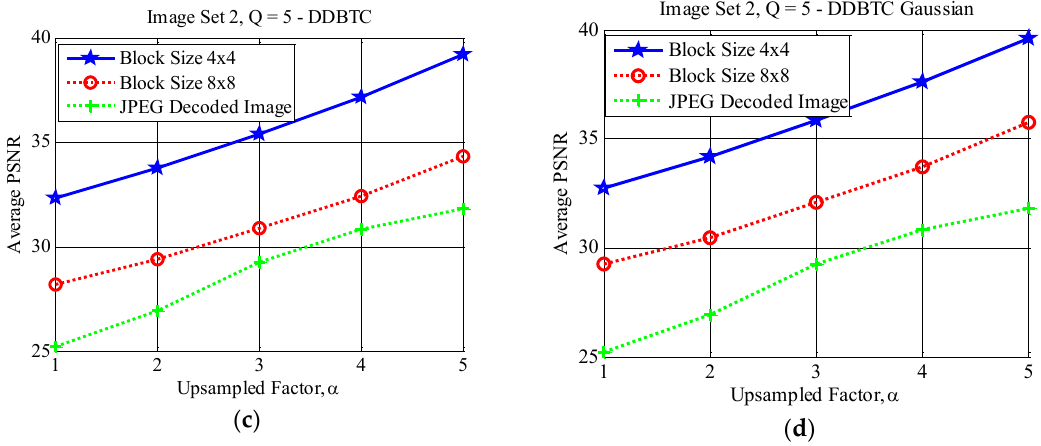
Figure 20. Effect of image block sizes on Image Set 2 with 𝑄 = 5 over ( a ) ODBTC; ( b ) EDBTC; ( c ) DDBTC; and ( d ) DDBTC Gaussian scheme.